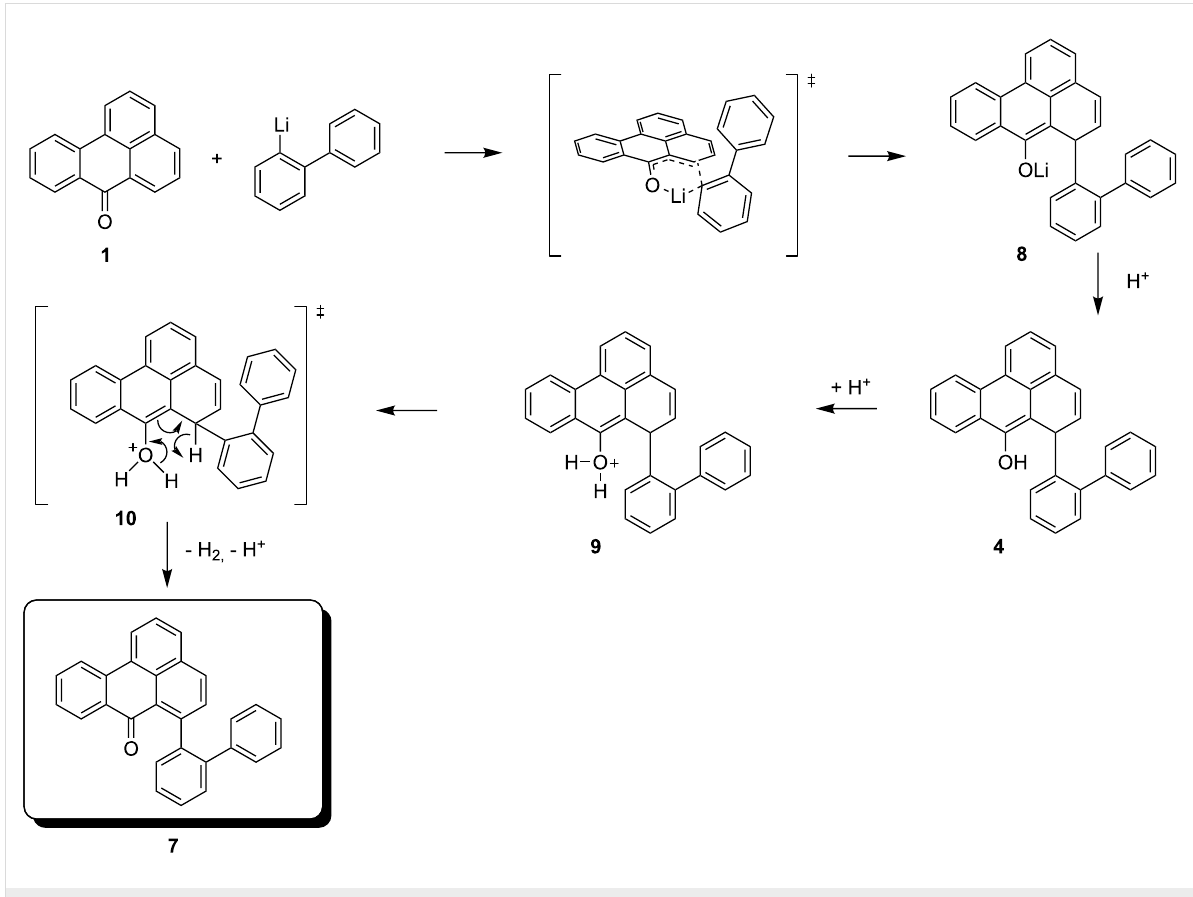
Scheme 2: Proposed mechanism for the formation of 4 and its oxidation to 7